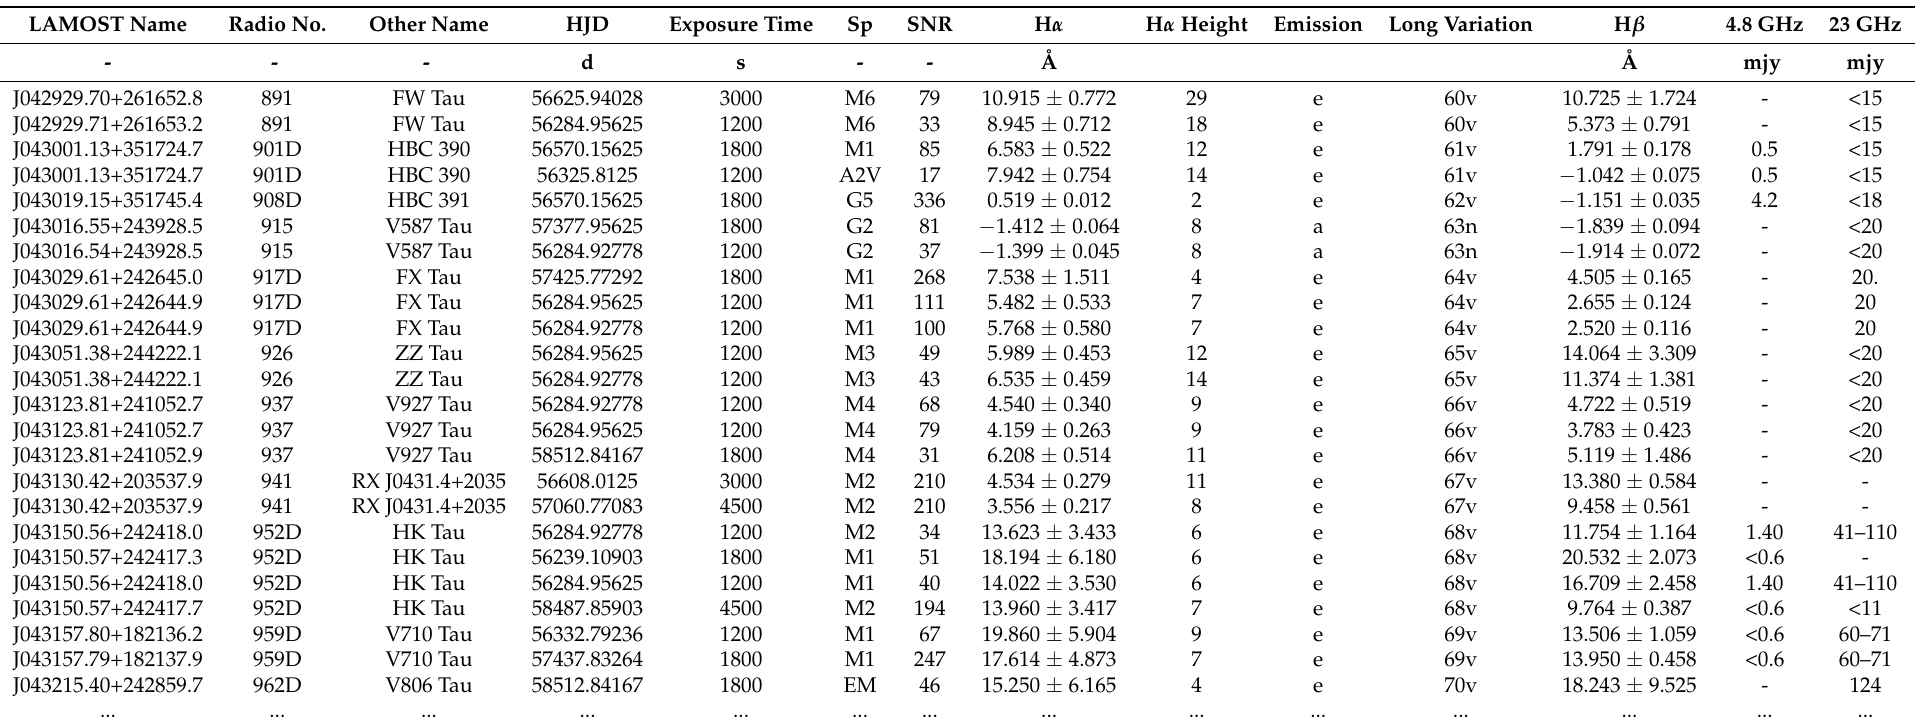
Table 2. Radio stars with repeated spectra from low resolution LAMOST survey DR7 and their H α variation in long time scales (several